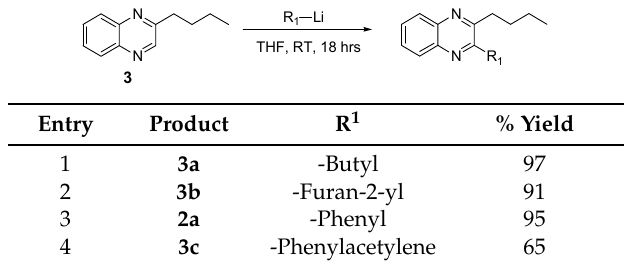
Table 2. Nucleophilic substitution on 2-butylquinoxaline.